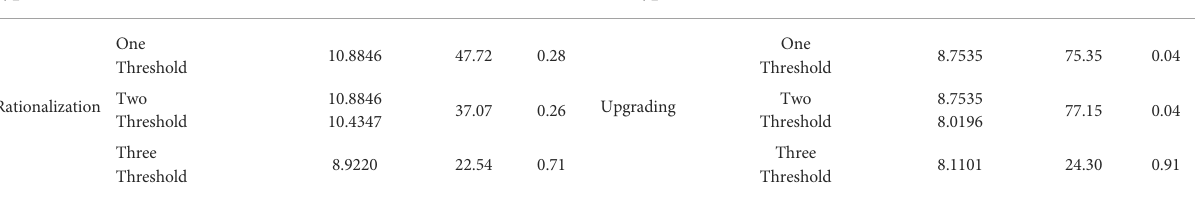
TABLE 8 Threshold variable test for the degree of environmental pollution.